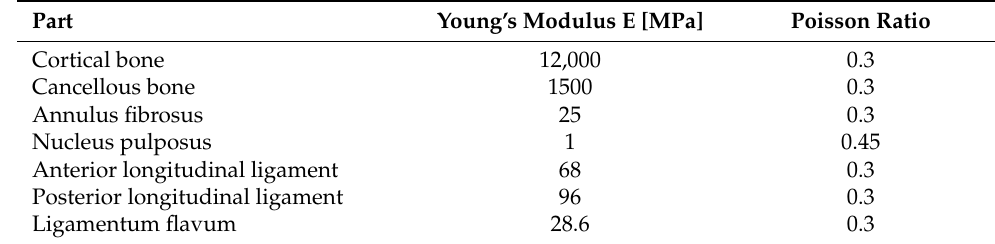
Table 1. Young’s modulus and Poisson’s ratio.